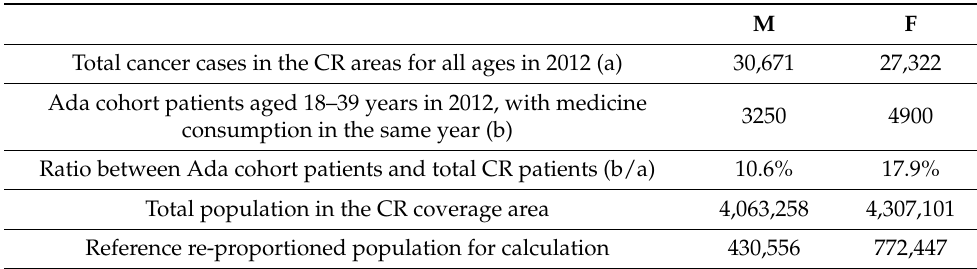
Table 1. Re-proportioning of the reference population.